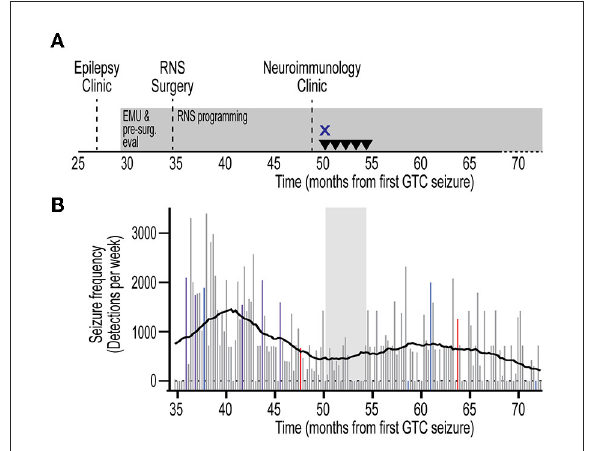
FIGURE3 Timeline of immunotherapy and quantitative seizure analysis. (A) Timeline from initial referral to evaluation in Epilepsy clinic, pre-surgical evaluation, RNS surgery, and evaluation in Neuroimmunology clinic. Timeline depicted from first GTC seizure. Treatment with high-dose intravenous corticosteroids (X) and intravenous immunoglobulin (inverted triangle) are indicated. RNS programming and treatment continuously employed (gray rectangles). (B) Quantification of seizure frequency since RNS placement. Events were extracted from the Patient Data Management System (PDMS) and annotated to yield histogram of seizure frequency in 1-week bins. Missing data are represented as zero events. Data represent detections per week. RNS programming sessions depicted for corresponding week as detection-only change (red), treatment-only change (blue), or detection and treatment changes (violet). Non-programming weeks depicted in gray. Rolling average trendline represents 0 th order polynomial of 20 neighbors for each data point to aide in data visualization and reduce visual impact of data fluctuations. Corresponding time of immunotherapy shown (gray shaded area). Note the lack of significant change in seizure frequency during, and following, immunotherapy. RNS, responsive neurostimulator; EMU, epilepsy monitoring unit; GTC, generalized